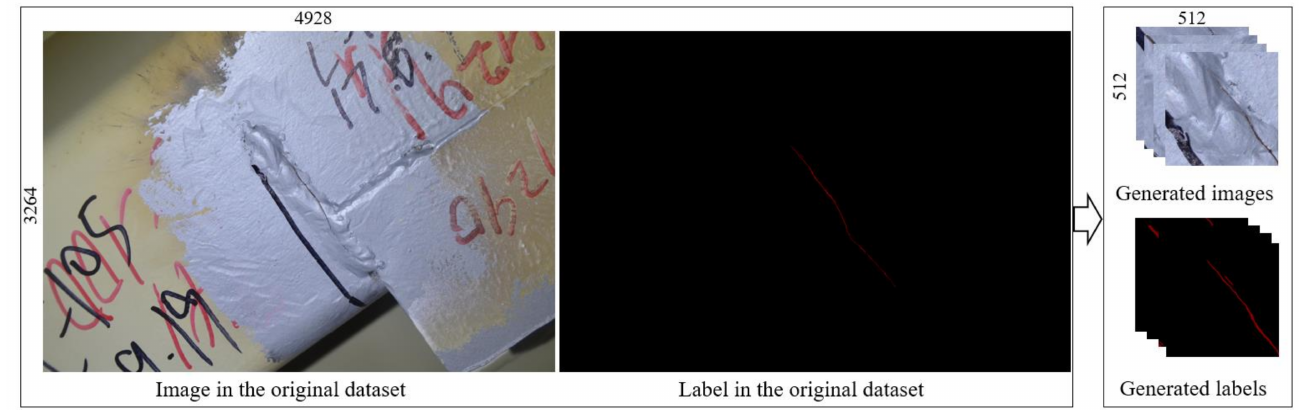
Figure 2. Overview of dataset